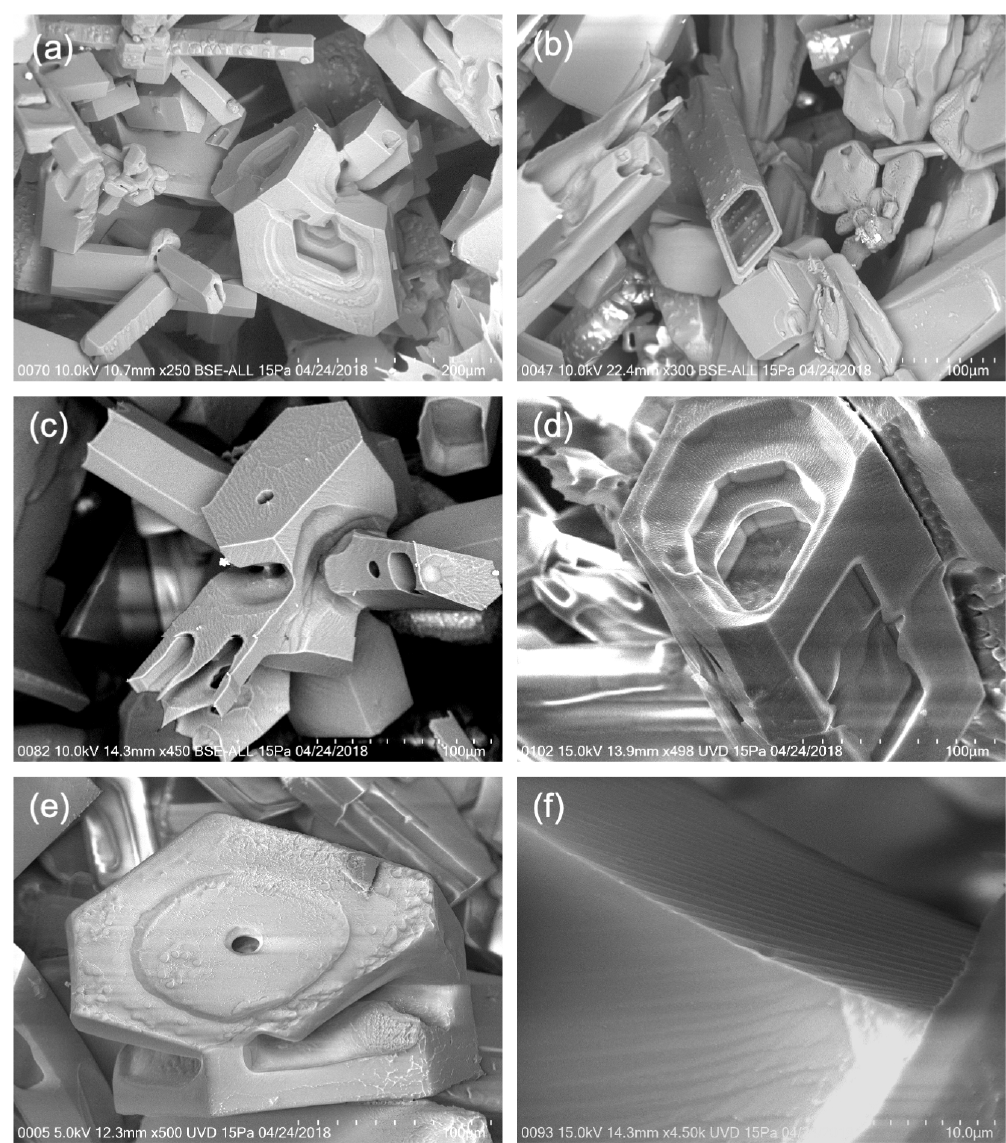
Figure 3. Moderate magnifications (250 × to 4500 × ) of particles, highlighting a wide variety of surface roughening characteristics. (a) Example of a compact-convoluted “outre polyhedron” near several bullet rosettes and non-classified sharp-faceted particles. On close inspec- tion, multiple patterns of roughness are visible, and there are several mineral aerosols (bright white). (b) Rhomboid column with prismatic linear roughening speckled with discrete surface adhesions, possibly from multiple growth cycles. (c) Rosette with mixed-aspect crystals and an array of geometric surface pits and high mesoscopic roughening. (d) Geometrically tiered and hollowed column of irregular basal cross- section with high roughening. (e) Outre polyhedron with central hole and irregular roughening. (f) High magnification of small, uniform angular